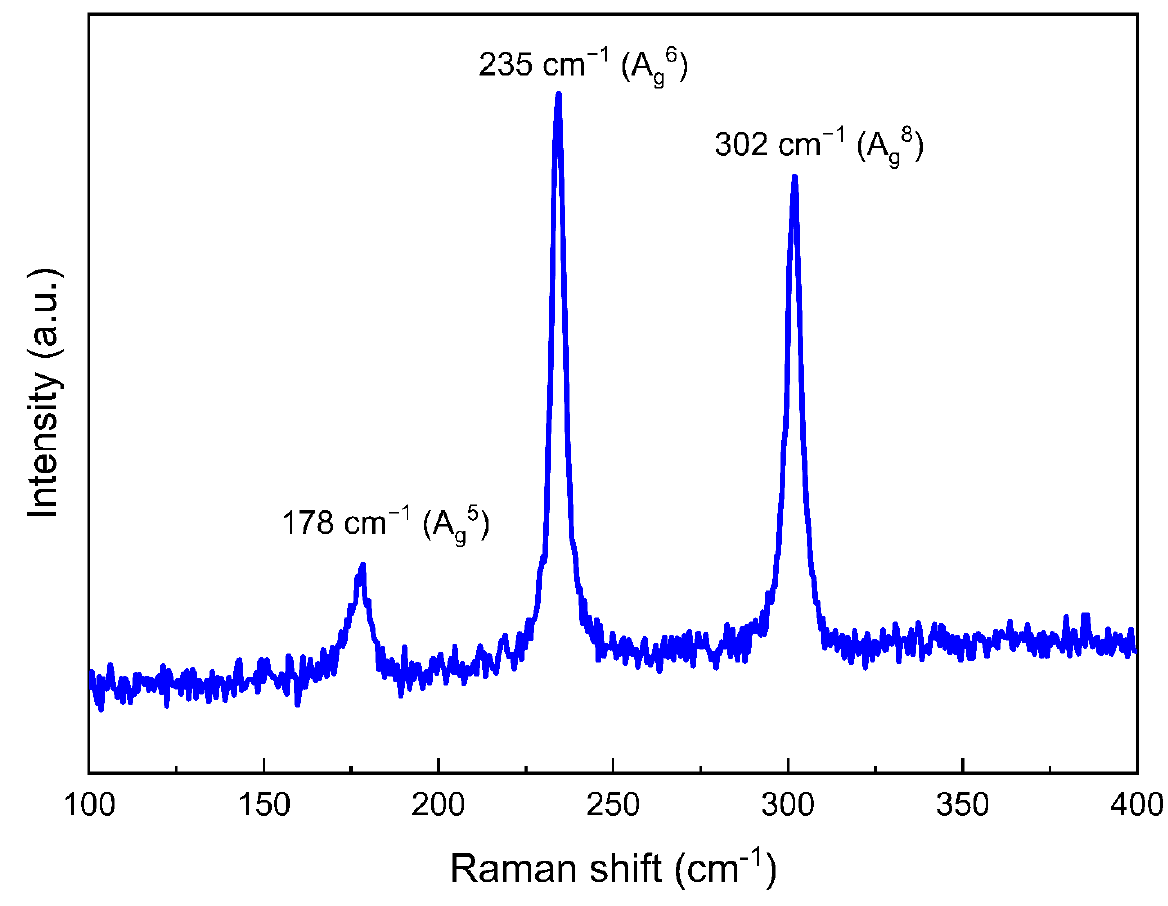
Figure 5. Raman spectrum of ZrSe 3 at 300 K.